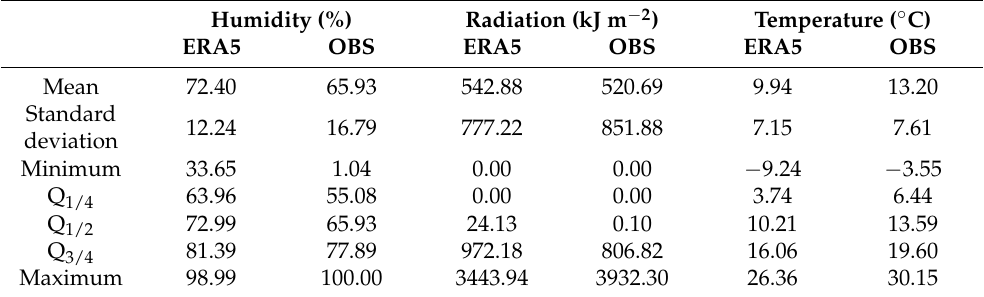
Table 2. Summary of the two types of meteorological data used in the study: ERA5 and observed.